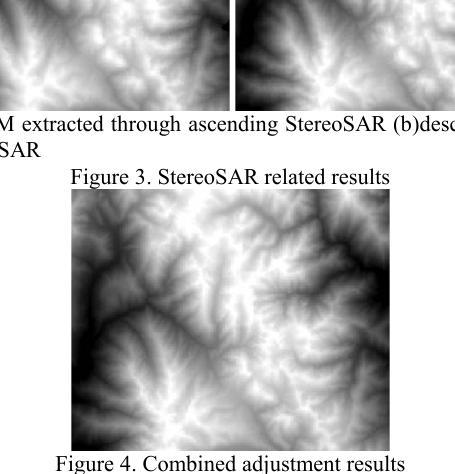
Figure 2. InSAR related results